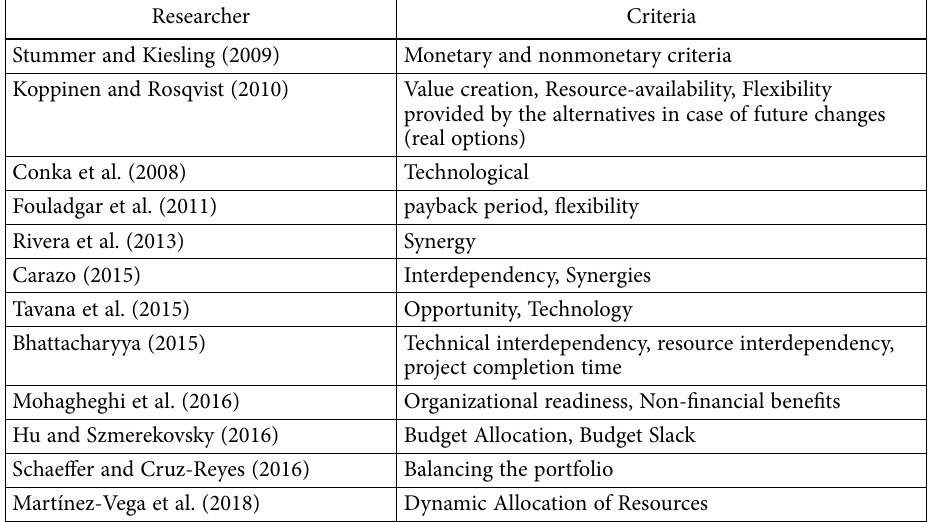
Table 8. Some of the other criteria used in